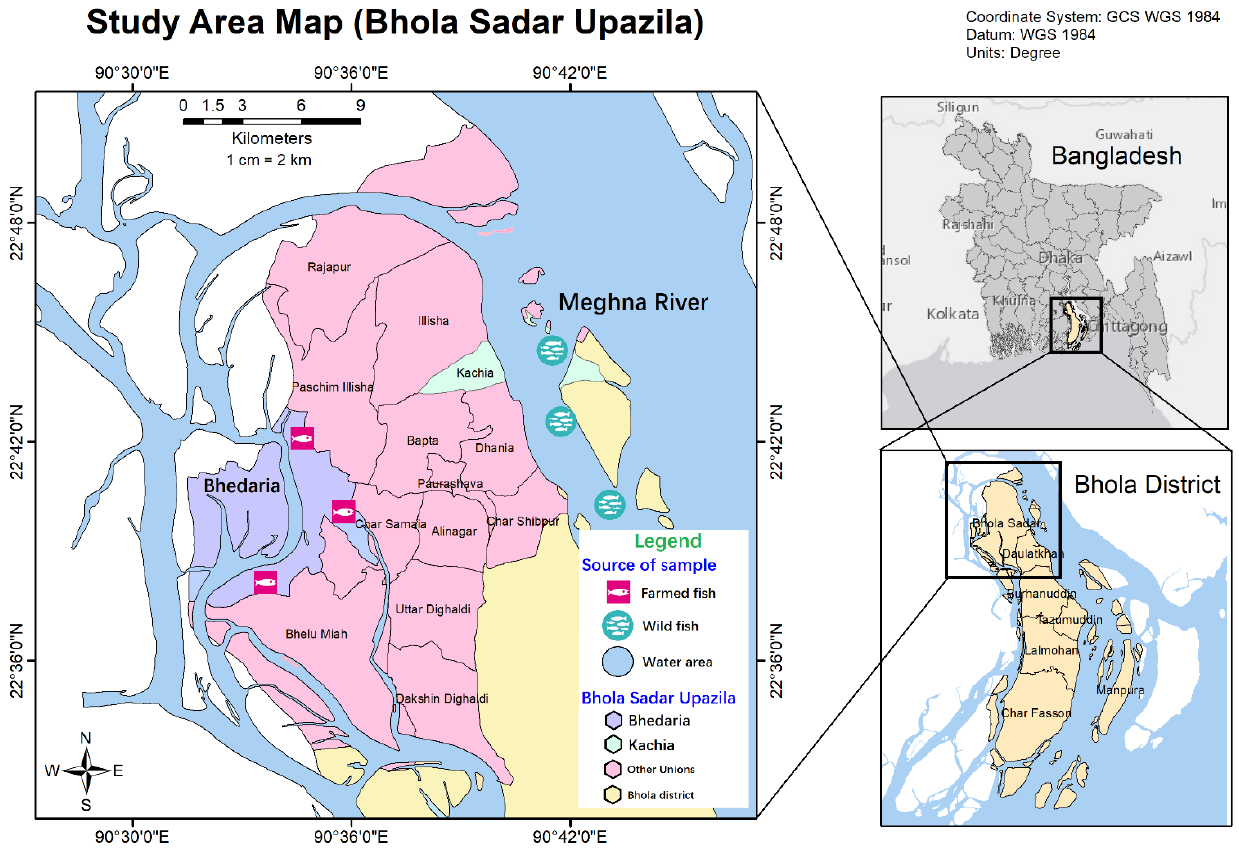
Figure 1. Geographical location of the sampling points of wild and farmed pangasius catfish.